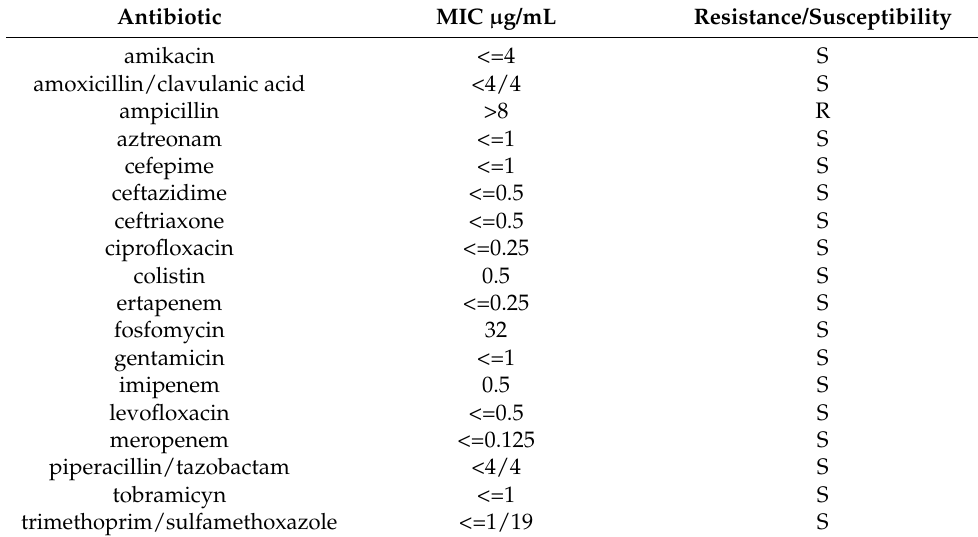
Table 1. Klebsiella pneumoniae antibiogram. MIC: minimum inhibitory concentration.